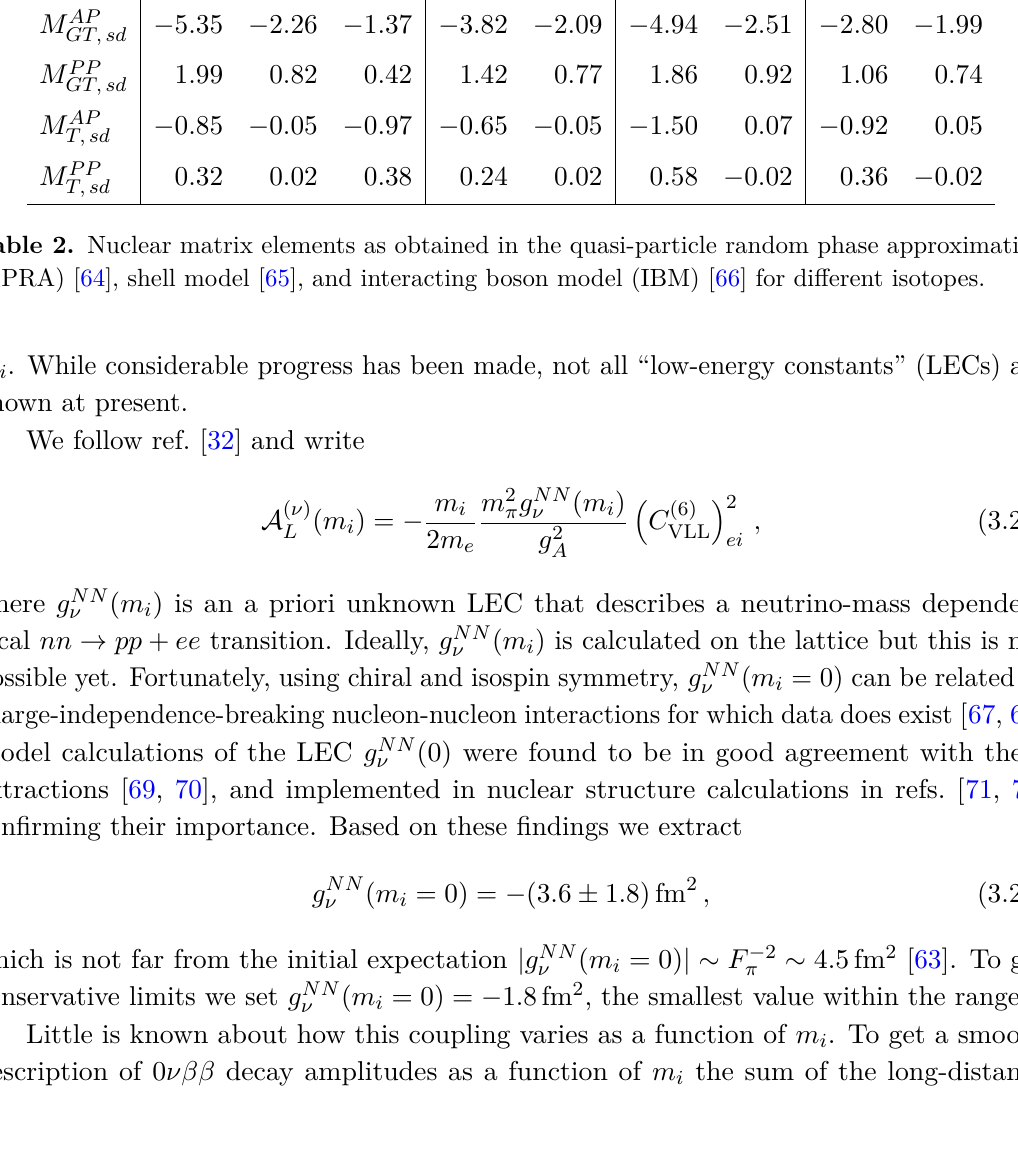
. While considerable progress has been made, not all “low-energy constants” (LECs) m i